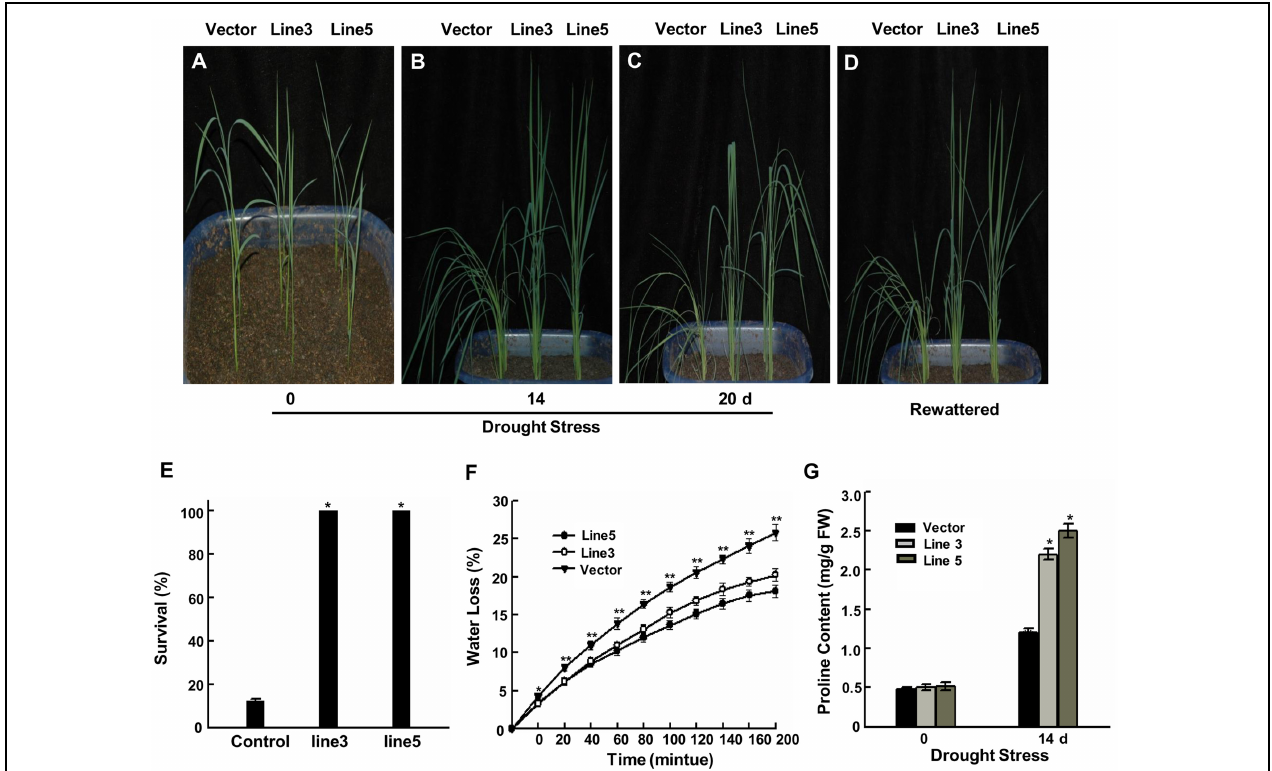
FIGURE 1 | Improved drought tolerance in AtWRKY57 transgenic rice. (A) Before drought treatment. (B) Drought for 14 days. (C) Drought for 20 days. (D) Recovery for 7 days after 20 days drought treatment. Drought stress was imposed on 4-week-old T3 transgenic seedlings in greenhouse. Drought experiments were repeated three times and at least 40 plants for each individual lines were used in each repeated experiment and one representative picture was shown. (E) Survival rate after 20 days drought stress. Values are mean ± SE ( n = 40 plants, ∗ P < 0.05). (F) Rate of water loss by detached leaves from control and transgenic plants. Values are the mean ± SE ( n = 6 plants, ∗∗ P < 0.01). (G) Proline content in the leaves of 4-week-old transgenic and control plants with or without drought treatments. Values are the mean ± SE of three independent experiments ( ∗ P < 0.05). FW, Fresh